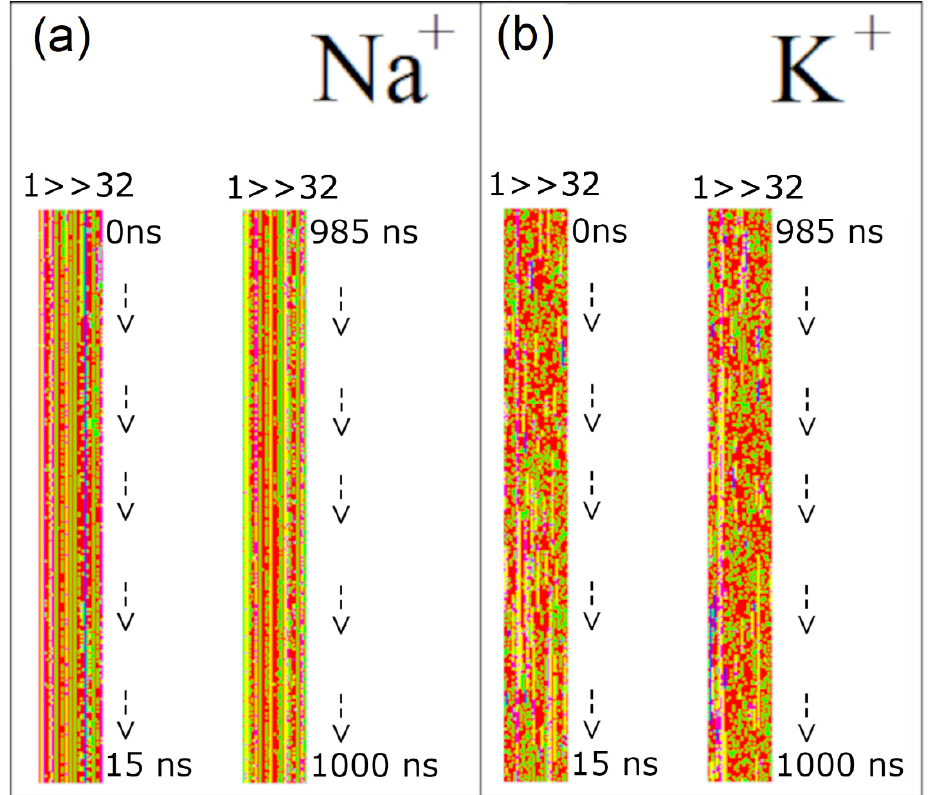
Figure 11. Change of dihedral angles of PASA’s main chain in each monomer in a simulation using FF14SB. Typical sections (at the start of the simulation (0–15 ns), at the end of the simulation (985–1000 ns)) ( a ) for a system with Na + counterions and ( b ) for a system with K + counterions. Each pixel illustrates the conformation of one monomer during 100 ps. The colors indicate the combination of ϕ and ψ dihedral angles corresponding to specific secondary structures: PPII helix, green; β -sheet structures, red; 3.10 helix, yellow; right-handed α helix, pink; left-handed α helix, blue.